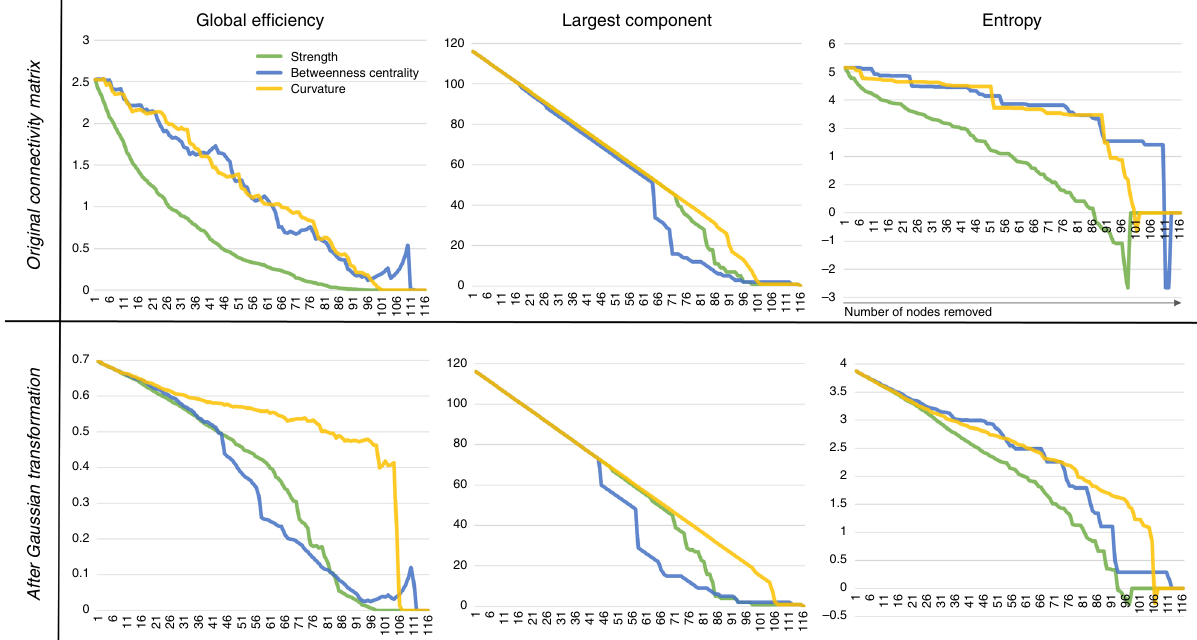
Fig. 5 Robustness analysis using node deletion for the lower resolution connectivity matrices (116 ´ 116) generated using the AAL atlas and MGH-USC DSI datasets. The size of the largest component, global ef fi ciency and entropy are computed (with or without transformation of the connectivity matrix weights) after targeted removal of nodes with decreasing strength, betweenness centrality, or curvature. The top row shows results for the original connectivity matrix while the bottom row shows results after Gaussian transformation of its weights as done in Alstott et al.